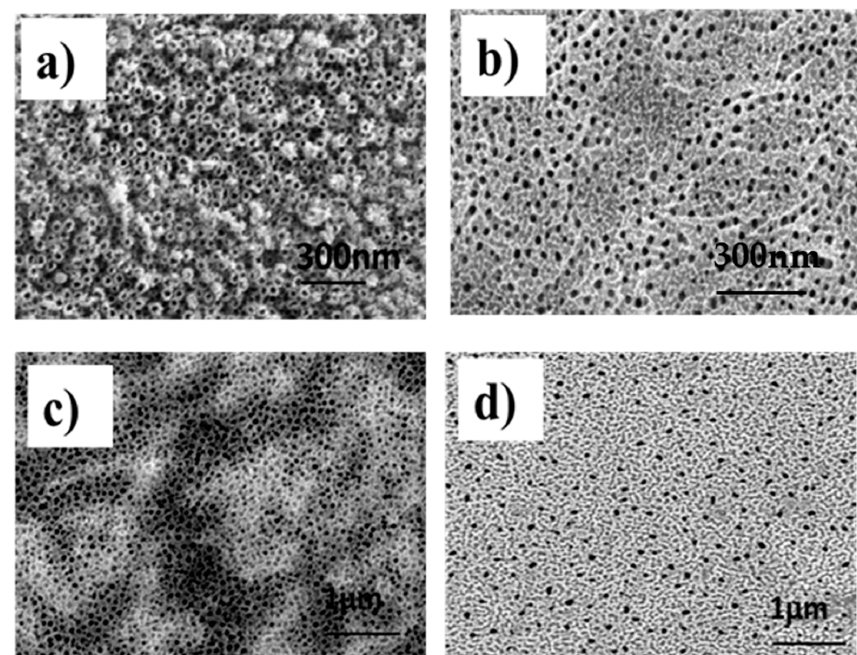
Figure 1. SEM images of Ti–30Ta alloy surface after nanotubes of TiO 2 growth in 0.25% NH 4 F + glycerol at 30 V for 9 h. ( a ) Group 2—anodized w/o annealing, ( b ) group 3—450 °C-nanotubes of TiO 2 annealed at 450 °C, ( c ) group 4—530 °C-nanotubes of TiO 2 annealed at 530 °C annealed and ( d ) group 5—600 °C-nanotubes of TiO 2 annealed at 600 °C.